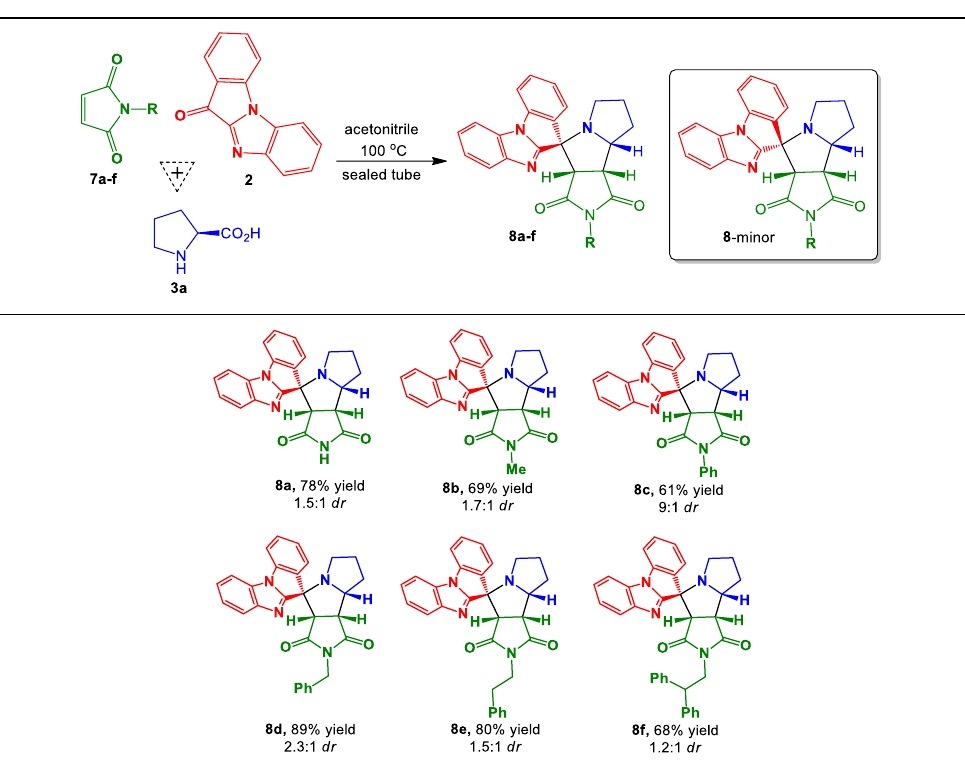
Table 4. Synthesis of Racemic Spiro-Adducts 8 via One-Pot Three-Component Reactions of Maleimides 7a–f, Ketone 2 and L -Proline 3a a,b,c.